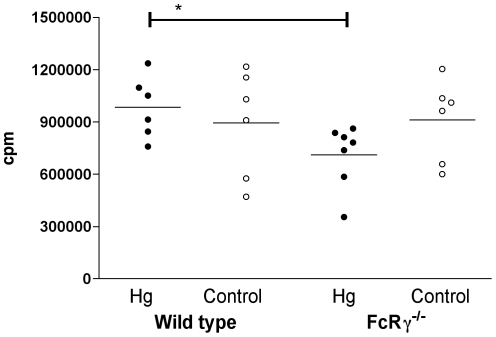
Uptake of circulating immune complexes in the liver.Uptake of preformed circulating HSA/DNP-IgG immune complexes in the liver of female BALB/c wild type and FcRγ−/− mice following 15–17 days of treatment with 15 mg/L HgCl2 in the drinking water or drinking water without any addition of Hg (controls). The bars denote mean ± SD. * p<0.05 (Mann-Whitney's test).